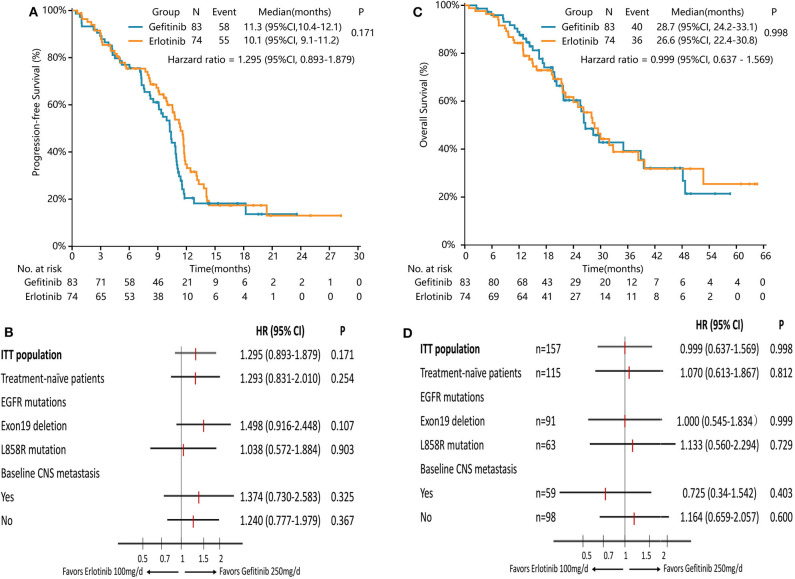
Survival analysis in the full-analysis set and subgroups by clinical characteristics. (A) Kaplan-Meier curves of PFS in the full-analysis set. (B) Subgroup analysis of PFS by the line of treatment, EGFR mutation types, and baseline CNS metastasis. (C) Kaplan-Meier curves of OS in the full-analysis set. (D) Subgroup analysis of OS by the line of treatment, EGFR mutation types, and baseline CNS metastasis.